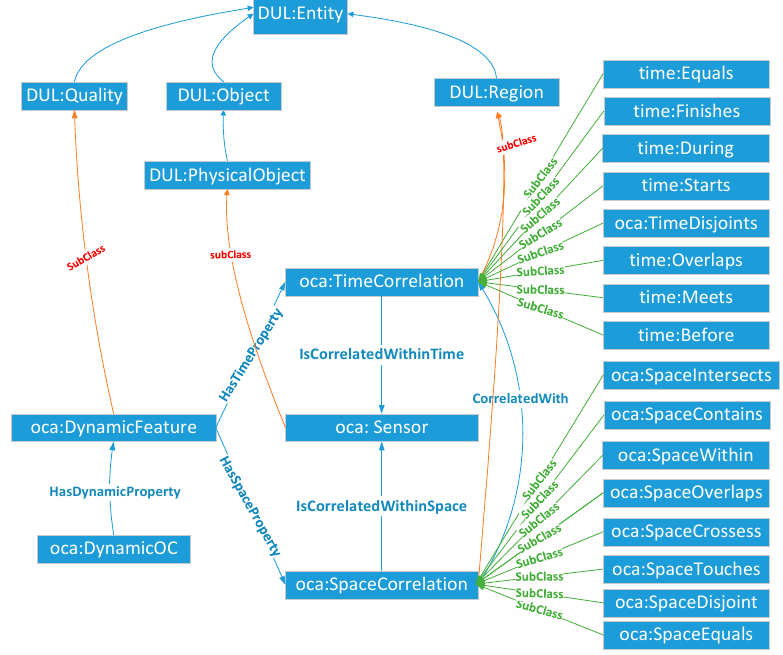
Figure 6. Core classes of the DynamicOC module.